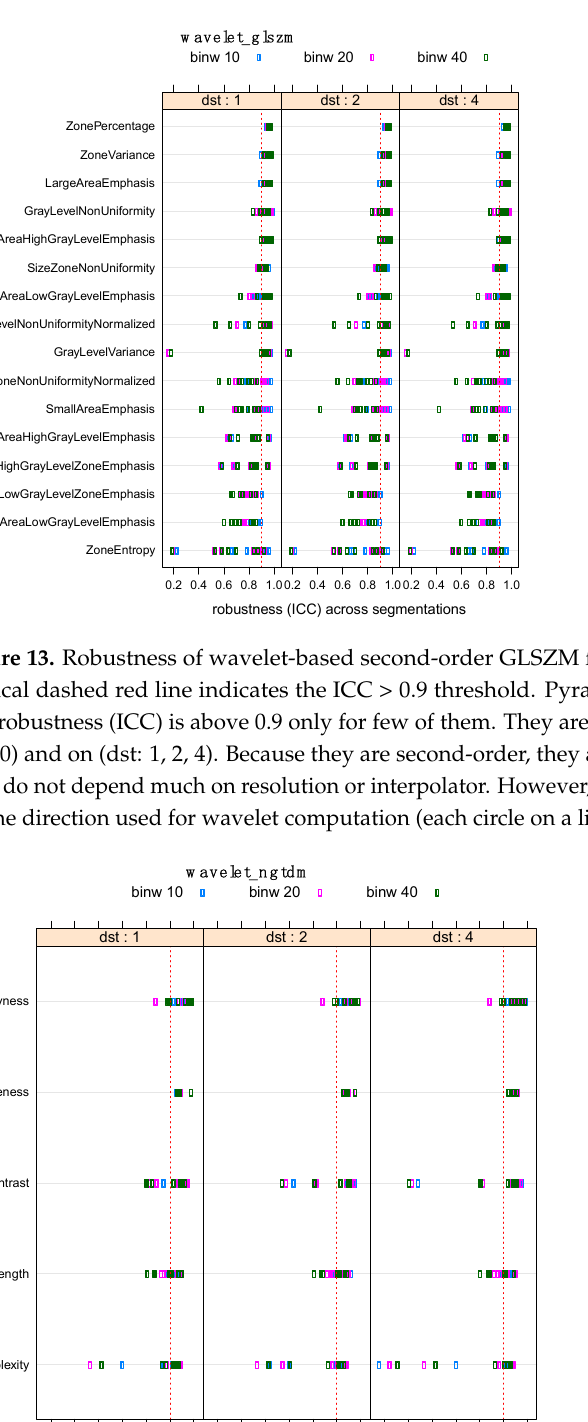
Figure 14. Robustness of wavelet-based second-order NGTDM features across segmentations. The vertical dashed red line indicates the ICC > 0.9 threshold. Pyradiomics provides five such features. The robustness (ICC) is above 0.9 only for few of them. They are dependent on bin-width (binw: 10, 20, 40) and on (dst: 1, 2, 4). Because they are second-order, they are dependent on distance (dst) but they do not depend much on resolution or interpolator. However, the wavelet features are dependent on the direction used for wavelet computation (each circle on a line is a different gradient direction).